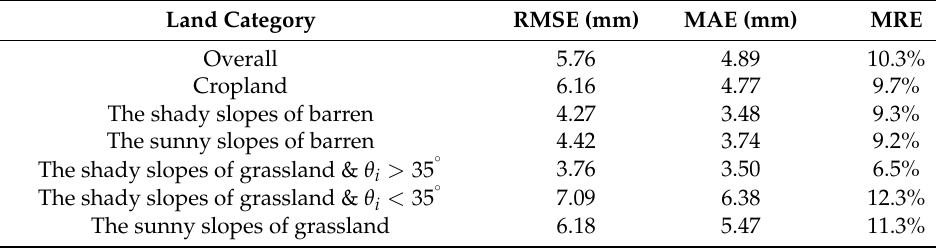
Table 5. Optimization model inversion accuracy analysis.